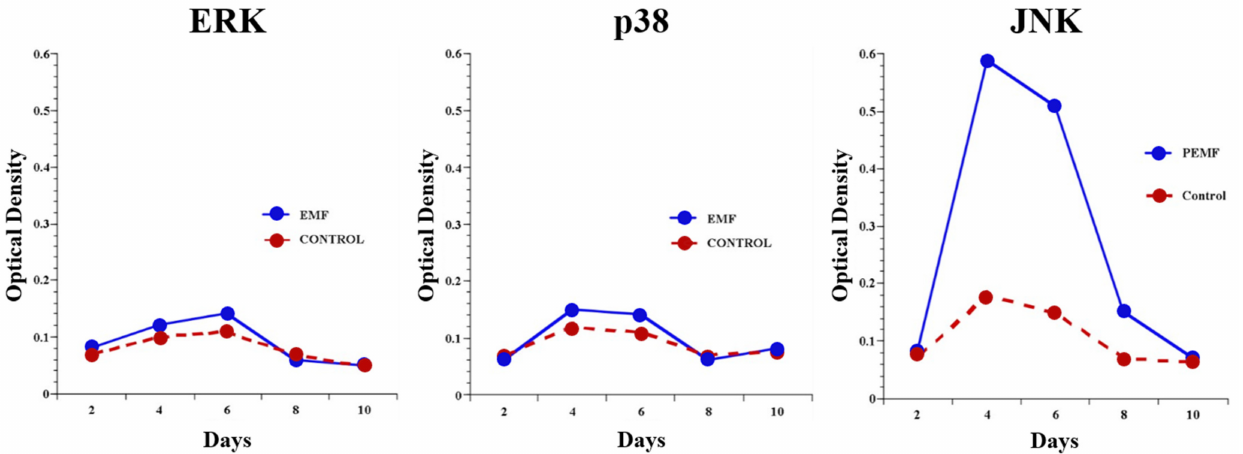
Figure 12. MAPK phosphorylation with PEMF exposure. Western blot analysis of the MAP Kinase proteins JNK, ERK, and p38, as well as their phosphorylated counterparts, indicates that of the three, only JNK is affected by exposure to PEMFs. Basal levels of JNK protein are expressed consistently with normal development; however, the phosphorylated protein is significantly elevated by a factor of greater than 3-fold. Adapted from Ref. [23]. 2004. Roy K.